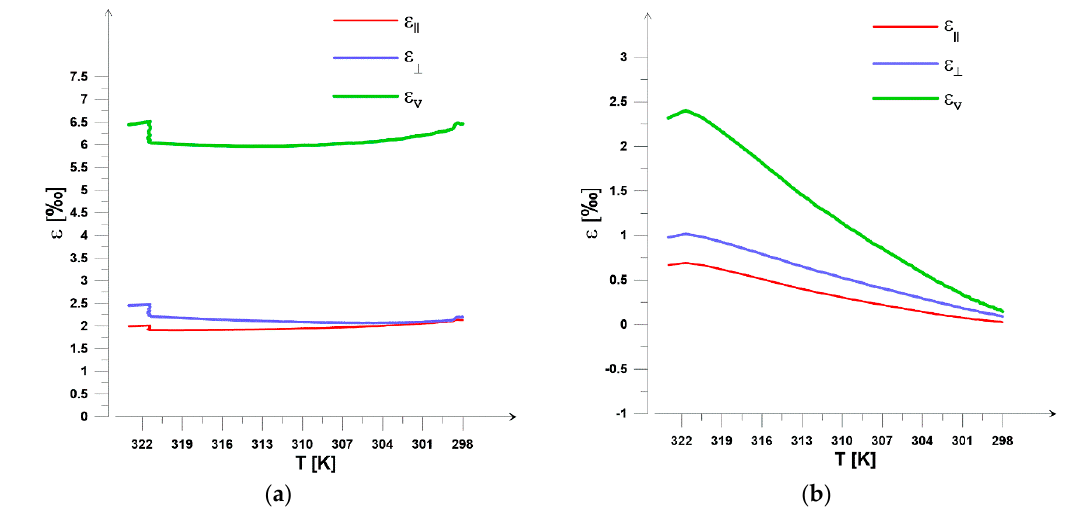
Figure 5. Volumetric ( ε V ) and linear strains during temperature decreases for ( a ) CO 2 and ( b ) CH 4 .